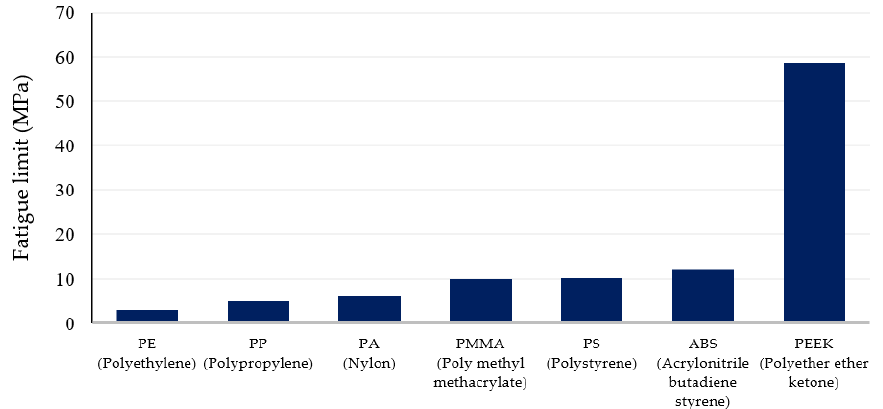
Figure 6. Endurance limit of some plastics used as 3D printing filaments [32–34].